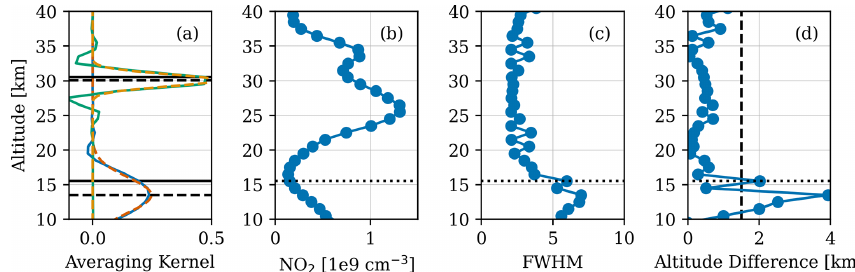
Figure 4. NO 2 retrieval diagnostics for OSIRIS scan 3292102 (8 March 2007, 23.9 ◦ N). (a) Averaging kernels at 15.5km (blue) and 30.5km (green). The dashed red line is the Gaussian fit to the 15.5km averaging kernel and the dashed orange line is the Gaussian fit to the 30.5km averaging kernel. The solid black lines mark the retrieval altitudes and the dashed black lines mark the peak altitude of the Gaussian fits. (b) NO 2 profile. (c) FWHM of the averaging kernels. (d) Difference between averaging kernel altitude and reported retrieval altitude. The dashed black line marks a difference of 1.5km. In the last three panels the dotted black line is the altitude at which the kernel filter would cut off this